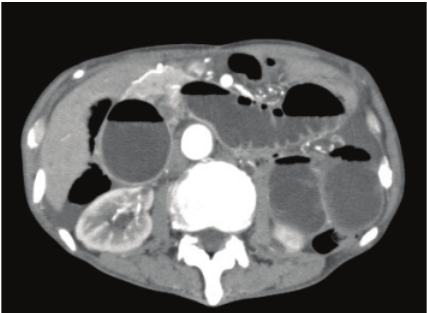
Figure 1: Abdominal computed tomography scan revealed dilation of the duodenum and small intestine in the left upper quadrant.